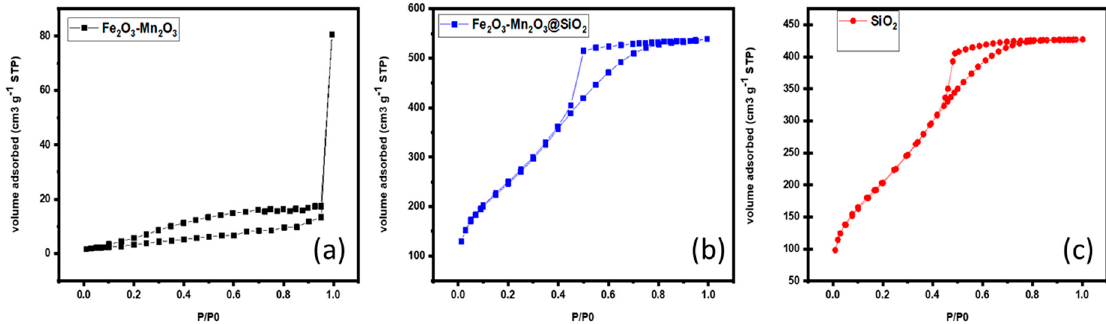
Figure 2. N 2 adsorption–desorption isotherm of synthesized ( a ) Fe 2 O 3 /Mn 2 O 3 nanoparticles (FM − NPs), and ( b ) Fe 2 O 3 /Mn 2 O 3 @SiO 2 (FMS), and ( c ) bare SiO 2 . Table 1. Surface area and porosity properties of synthesized materials .